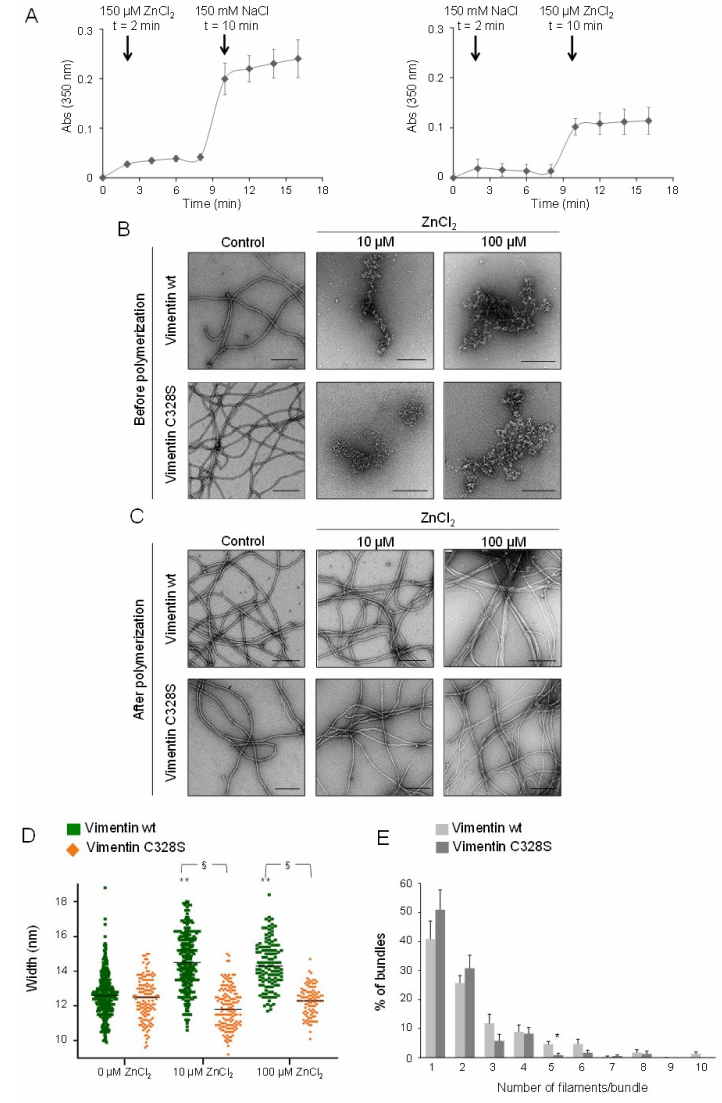
Figure 6. Impact of zinc on the assembly of soluble vimentin and on the morphology of preformed filaments. ( A ) The e ff ect of ZnCl 2 and NaCl added in di ff erent orders, as indicted, on the turbidity of vimentin solutions was monitored at r.t. Results are the average values ± SD of three assays with similar results. ( B ) E ff ect of the preincubation of vimentin wt or C328S with vehicle or ZnCl 2 at the indicated concentrations for 1 h at r.t. on subsequent polymerization by the addition of 150 mM NaCl and incubation for an additional hour at 37 ◦ C. ( C ) Vimentin wt or C328S was first polymerized by incubation with 150 mM NaCl for 1 h at 37 ◦ C, after which, ZnCl 2 at the indicated final concentrations was added, and incubation was continued for 1 h at r.t. The morphology of vimentin wt or C328S filaments was assessed by EM. The images shown are representative of at least three independent assays with similar results. Scale bars, 200 nm. ( D ) The width of filaments shown in ( C ) was measured with FIJI and represented as a scatter plot. Results are the mean values ± SEM of 50 filaments per experimental condition (** p < 0.01 vs. wt-control; § p < 0.05 vimentin wt vs. C328S by Student’s t -test). ( E ) Images from preformed filaments of vimentin wt or C328S treated with 100 µ M ZnCl 2 were inspected for filaments appearing as individual entities or forming laterally associated groups or bundles. Then, the percentage of bundles containing the indicated number of filaments was calculated. At least 230 bundles were counted per experimental condition. Results are the average values ± SEM of four and three assays for vimentin wt and C328S, respectively (* p < 0.02 vs. wt by Student’s t